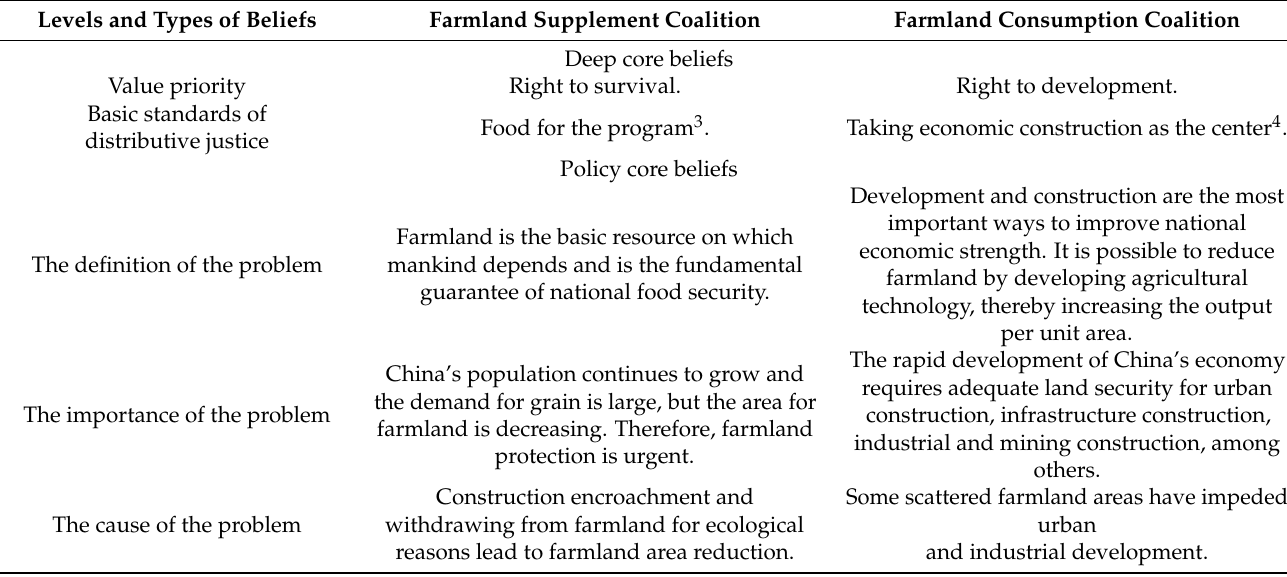
Table 3. The advocacy coalitions’ belief systems on farmland